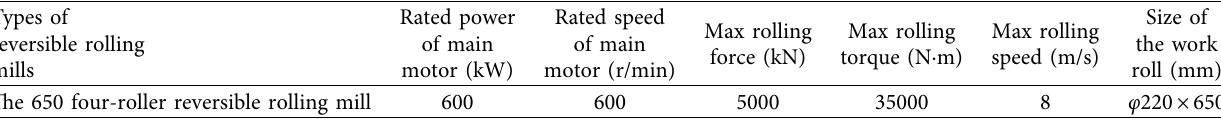
Table 4: Main parameters of the 650 four-roller reversible rolling